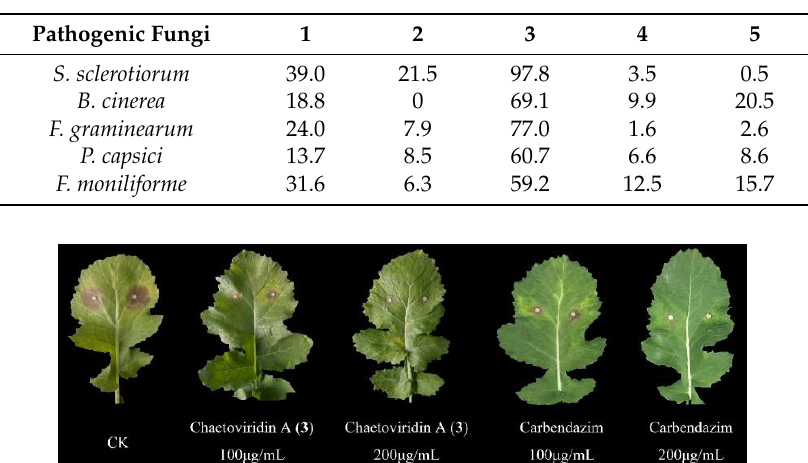
Figure 4. Effects of chaetoviridin A ( 3 ) against S. sclerotiorum -infected cole leaves. CK, control check (5% DMSO without compounds).